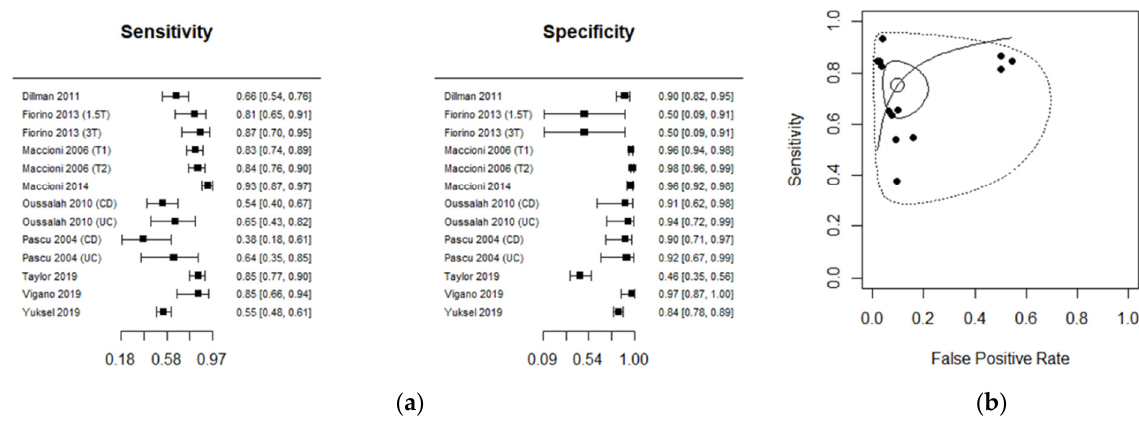
Figure 3. ( a ) Forest plot and ( b ) the summary receiver operating characteristic (ROC) curve illustrating the summary operating point for the diagnostic performance of MRI.